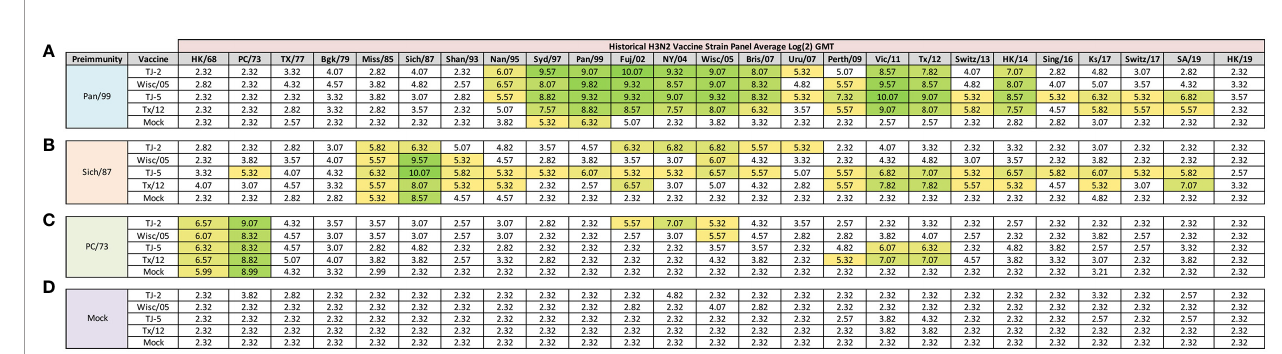
FIGURE 3 | Day 98 H3N2 Historical Vaccine Strain HAI Panel. Serum collected from animals 98 days post infection (14 days after fi rst vaccination) was analyzed for HAI activity against a panel of historical H3N2 in fl uenza vaccine strains spanning 1968-2019. Table is divided into sections based on the virus each animal received to establish preimmunity: A/Panama/2007/1999 (A) , A/Sichuan/2/1987 (B) , A/Port Chalmers/1/1973 (C) , or PBS (Mock) (D) . Cells in table are color coded as a heat map based upon Log(2) HAI geometric mean titer (GMT) for each group of ferrets (N=4). The heat map colors cells yellow at Log(2) GMT of 5.32 which correspond to an HAI titer of 1:40 and cells become a darker shade of green as the average antibody titer of the group increases. Cells with no color correspond to groups that did not achieve a GMT ≥